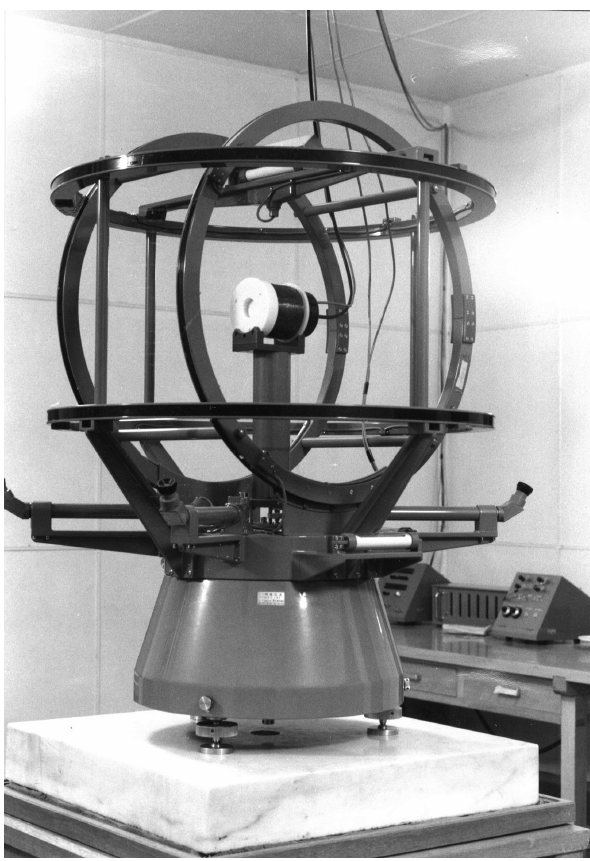
Figure 22. MO-P theodolite (photo supplied by Kakioka Magnetic Observatory).